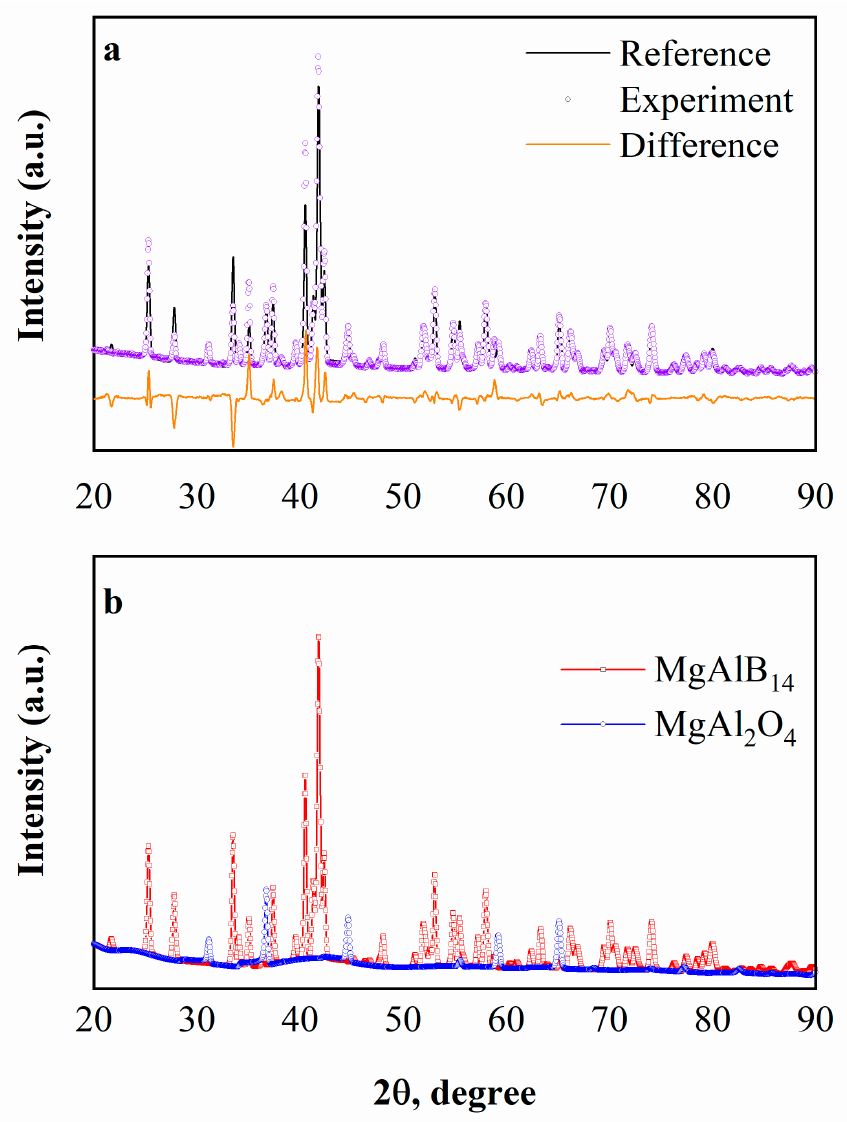
Figure 1. XRD patterns of the spark plasma sintered AlMgB 14 samples: ( a ) 1—experimental XRD pattern (violet symbols), 2—integral intensity found using the Rietveld method (black line), 3—difference between experimental and integral intensities (orange line); ( b ) theoretical XRD patterns of the AlMgB 14 and MgAl 2 O 4 phases, found using the Rietveld method.